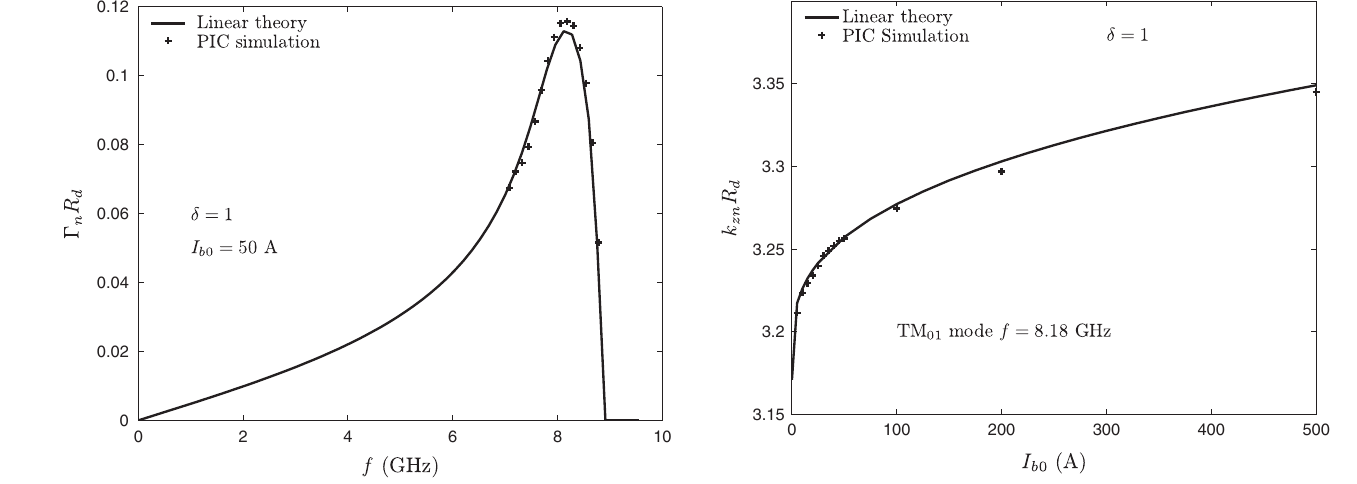
FIG. 18. Normalized wave number for the TM 01 mode as a function of beam current for (cid:1) ¼ 1 .